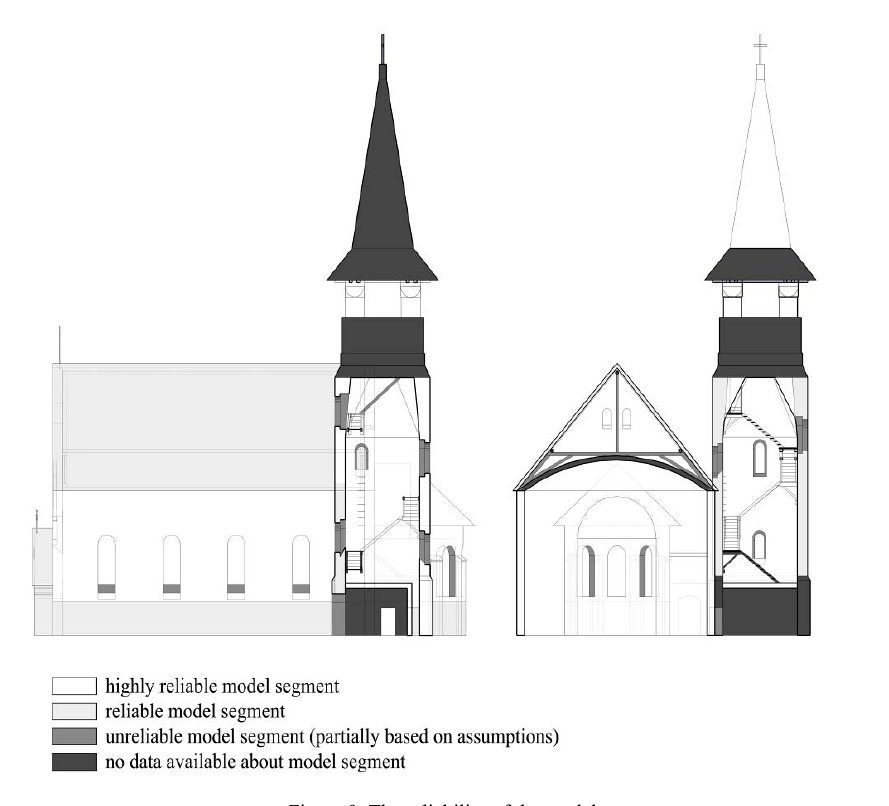
Figure 9. The reliability of the